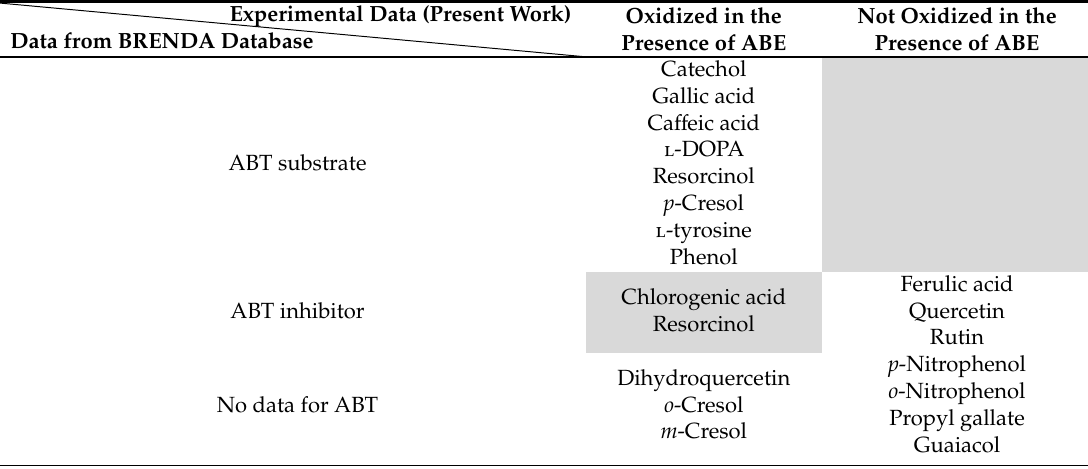
Table 3. Substrate specificity (ABE—crude Agaricus bisporus extract, ABT isolated tyrosinase from Agaricus bisporus ). Gray color represents the two possible contradicting subsets between experimental data from the present work and the data from the BRENDA database: (1) compounds oxidized by ABE, but marked as ABT inhibitors; and (2) compounds not oxidized by ABE, but marked as ABT substrates. DatabaseExperimental Data (Present Work) Oxidized in the Data from BRENDA ABT substrate ABT inhibitor No data for ABT